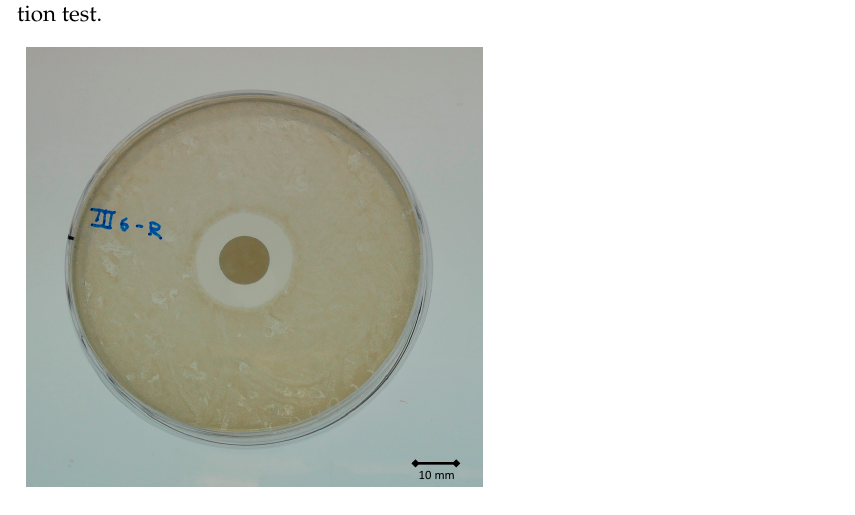
Figure 3. Zone of inhibition of the eluted gentamicin from the specimen, after 7 d of immersion in the test solution, against a clinical isolate of S. aureus.